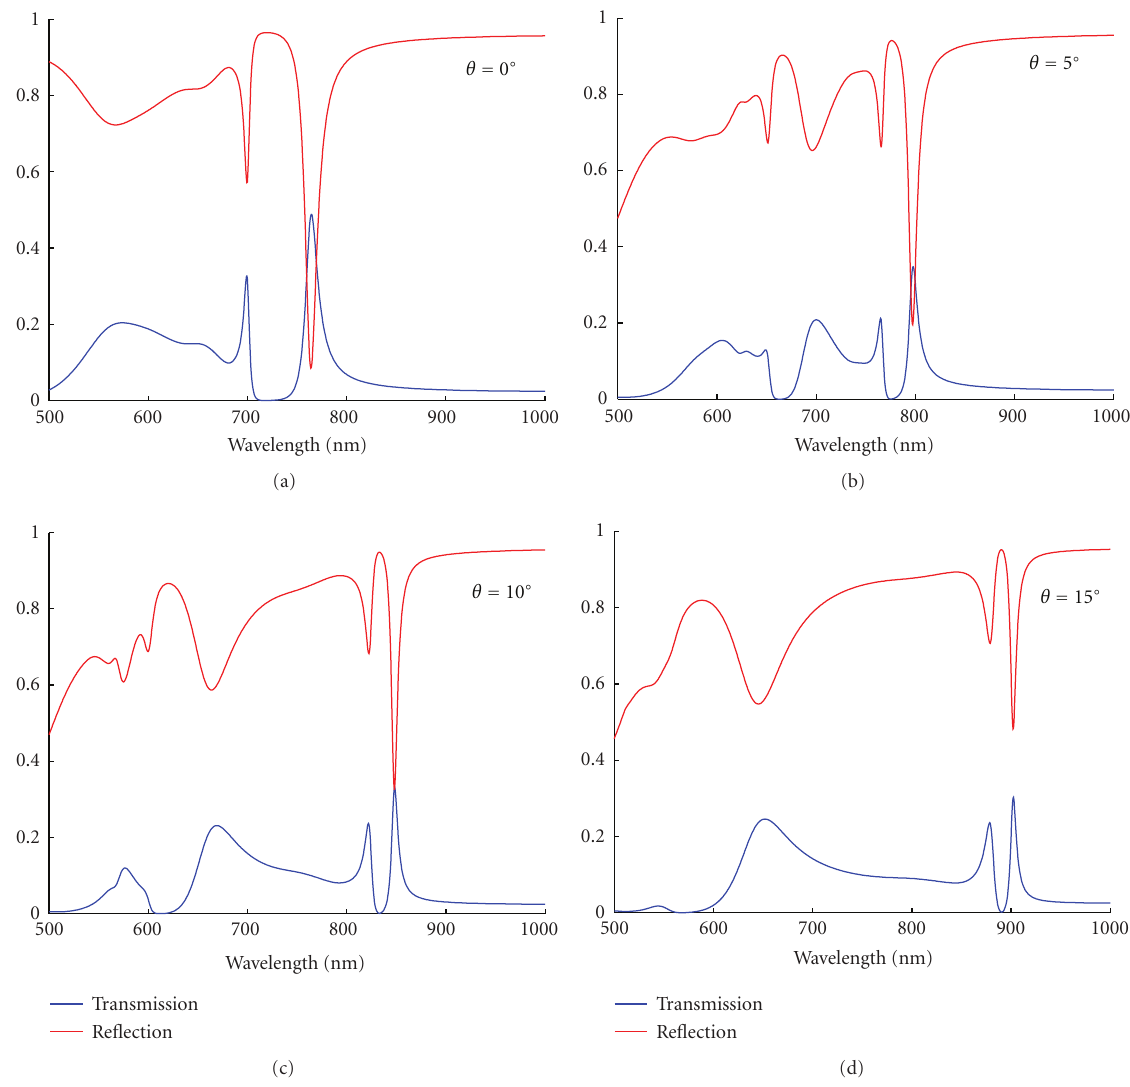
Figure 5: Parametric analysis of the transmission and the reflection diagrams of a free-standing array of gold strips computed for (a) θ = 0 ◦ , (b) θ = 5 ◦ , (c) θ = 10 ◦ , and (d) θ = 15 ◦ . The geometrical parameters are p = 700 nm, w = 150 nm, and l =